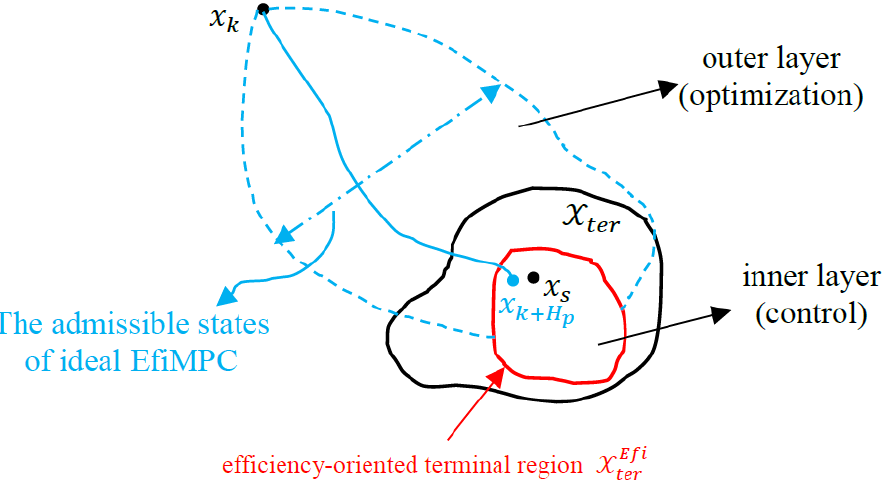
Figure 2. Illustration of ideal efficiency-oriented MPC.